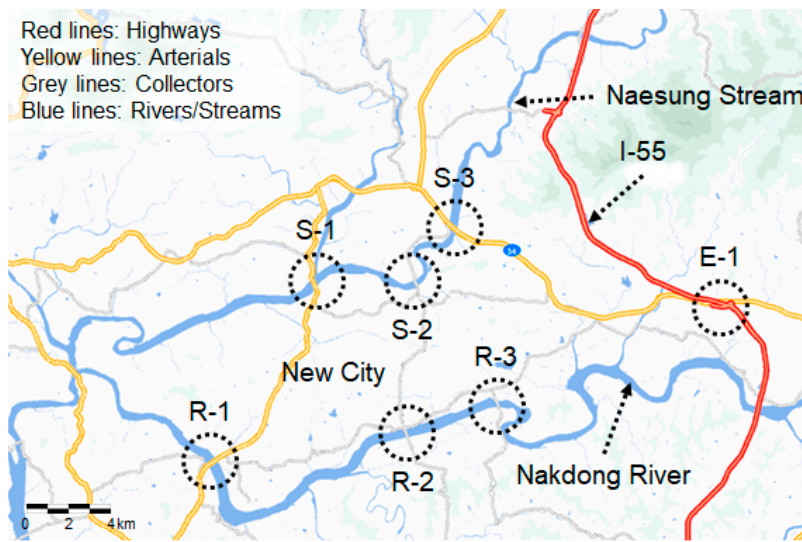
Figure 1. A map of the new administrative capital of North Gyeongsang Province.